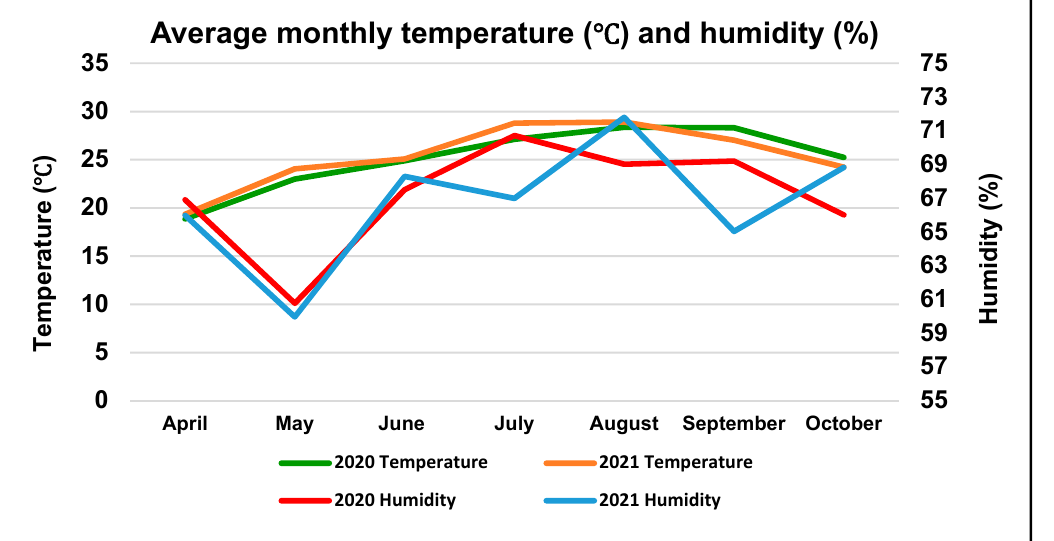
Figure 1. Average monthly temperature (°C) and humidity (%) of the experimental site during summers 2020 and 2021.